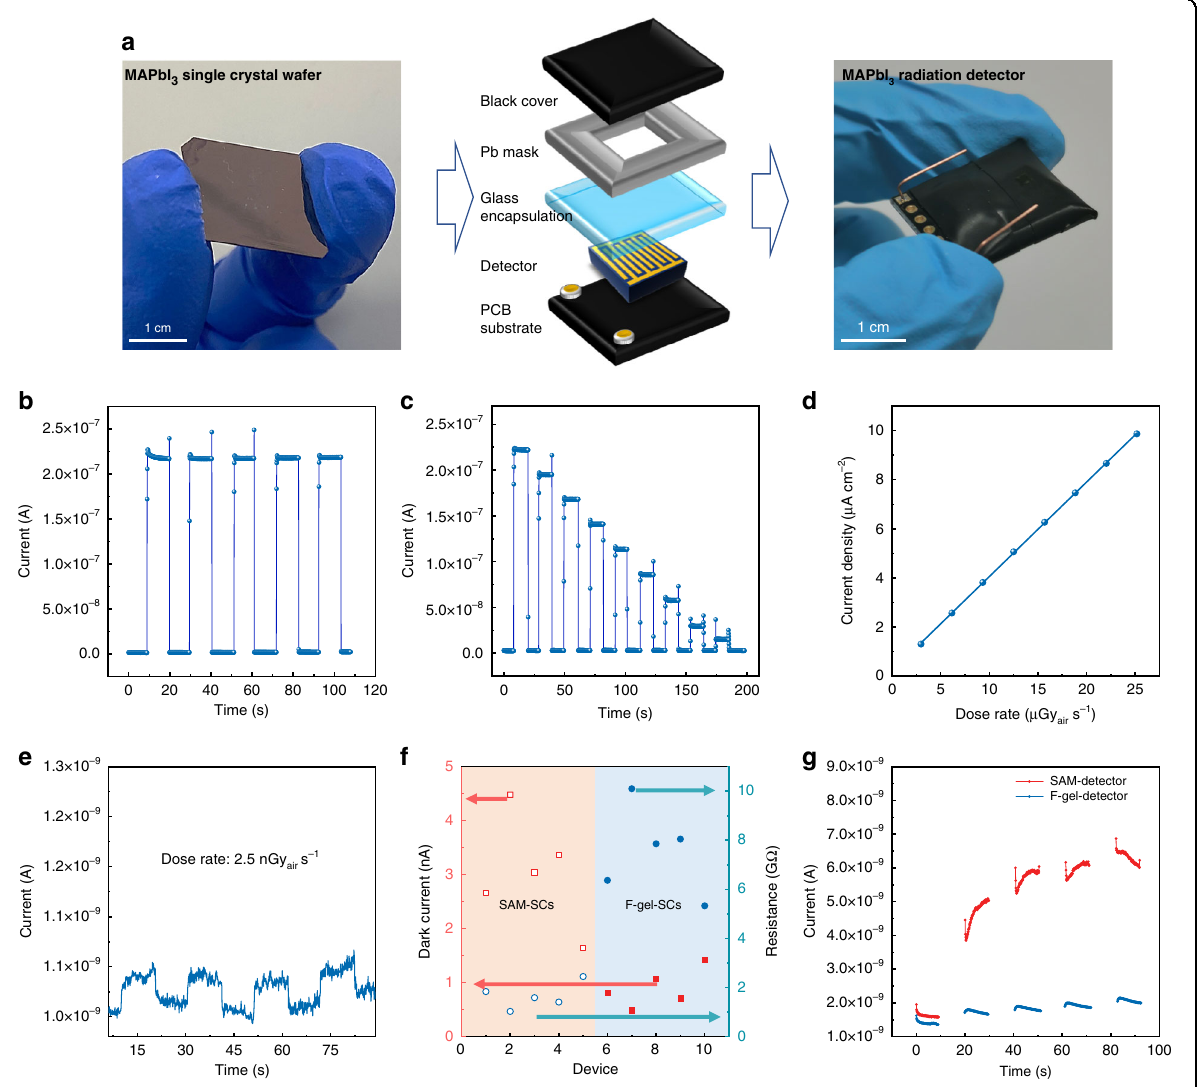
Fig. 4 X-ray detection performance of the MAPbI 3 SC devices. a Photographs of F-gel-SC wafer (left), the corresponding radiation detector (right), and the schematic diagram of the device structure (middle). b The current response curve of the F-gel-detector when successively turning the X-ray on and off. c Current response curve of the F-gel-detector under various X-ray dose rates while successively turning on and off the X-ray. d Photocurrent variation as a function of X-ray dose rate of the F-gel-detector from ( c ). e Photocurrent response curves of the F-gel-detector measured at an ultralow X-ray dose (2.5 nGy air s − 1 ). f The statistics of dark current at 5 V bias and the corresponding resistance of crystals grown on different substrates. g The dark current variation after multiple light-dark cycles with X-ray